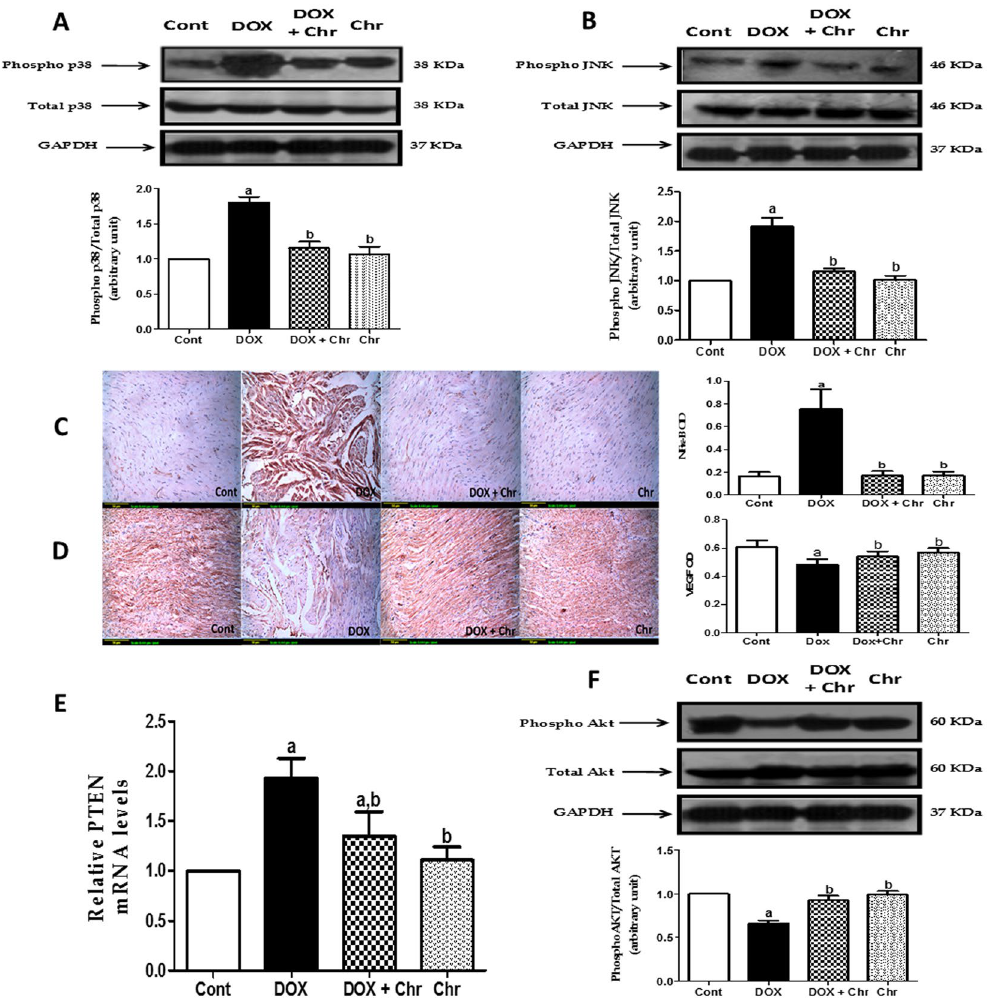
Figure 6. Effect of chrysin on NF- κ B, MAPK, VEGF, PTEN and AKT expressions in rats subjected to chronic doxorubicin (DOX) intoxication. ( A ) Protein expression of phospho and total p38 by western blot analysis and densitometric quantitation of the bands ( B ) Protein expression of phospho and total JNK by western blot analysis and densitometric quantitation of the bands. Blot densitometry was performed using Image J analysis software. GAPDH was used as a loading control. ( C ) Protein expression of NF- κ B by immunohistochemical staining ( D ) Protein expression of VEGF by immunohistochemical staining. Scale bar, 50 µ m (200x) and quantitative image analysis for immunohistochemical staining was expressed as optical densities (OD) across 10 different fields for each rat section. ( E ) Gene expression of PTEN. Quantitation of gene expression was done using real-time PCR. The levels of mRNA were normalized to that of GAPDH in each group. The mRNA levels of genes were expressed as relative quantification (RQ) compared to the control group. The value of genes in control group was defined as 1. ( F ) Protein expression of phospho and total AKT by western blot analysis and densitometric quantitation of the bands. Blot densitometry was performed using Image J analysis software. GAPDH was used as a loading control. Data are represented as as mean ± SD (n = 10). a or b: Statistically significant from the control or DOX group respectively at P < 0.05 using one-way analysis of variance ANOVA followed by Tukey-Kramer as a post-hoc